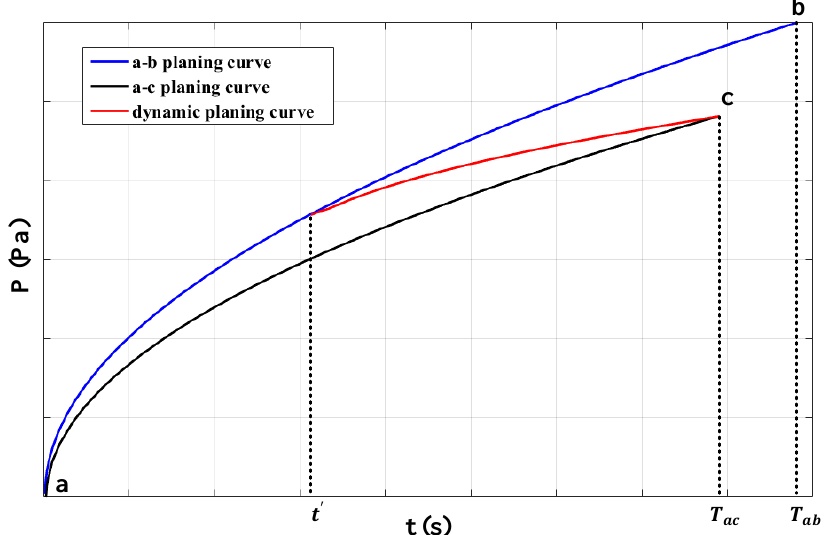
Figure 9. THEC-APC dynamic adjustment.